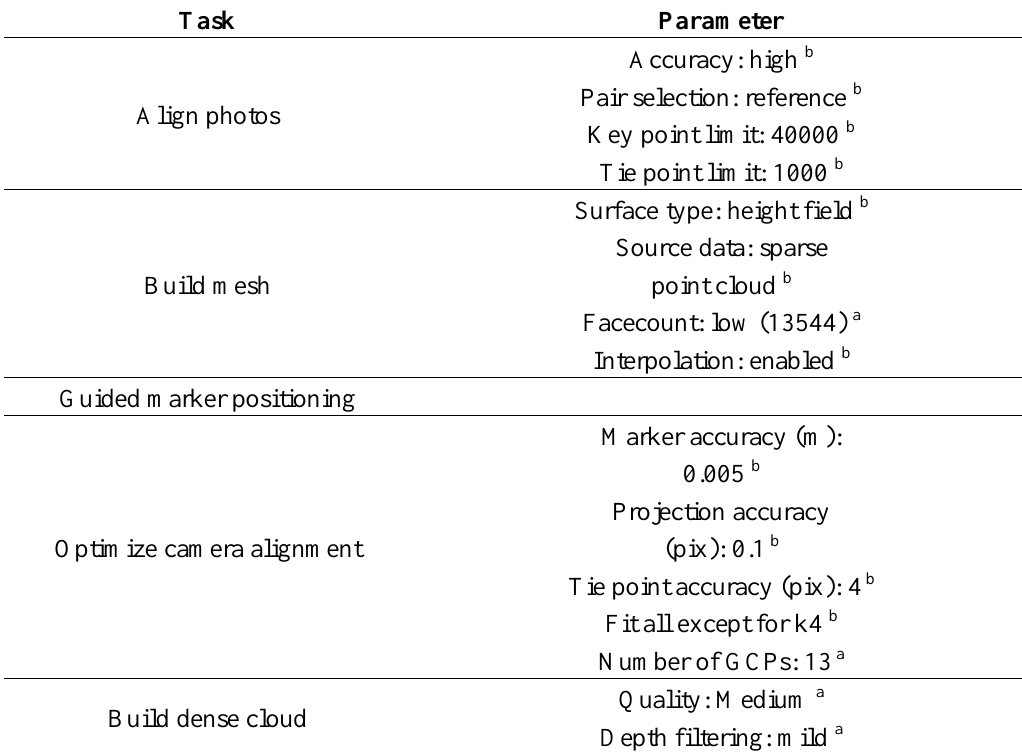
Table 3. Processing steps with corresponding parameters in Photoscan’s pipeline for the generation of 3D point clouds from UAS